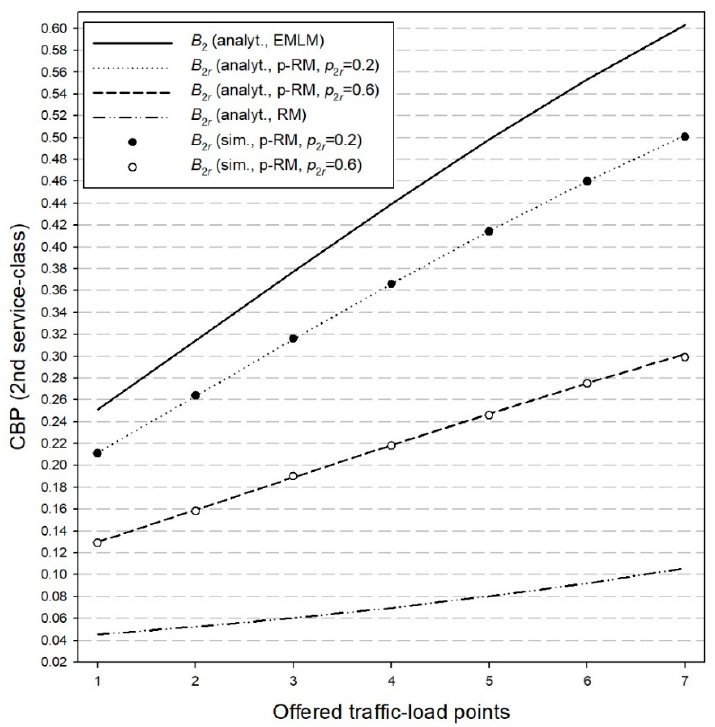
Figure 4. CBP—Second service-class (probabilistic retry loss model).